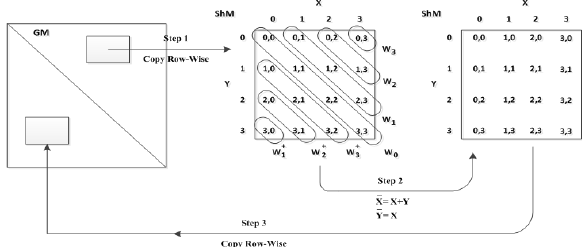
Figure 2: Threads and Elements mapping at each steps of the First Algorithm (Selective